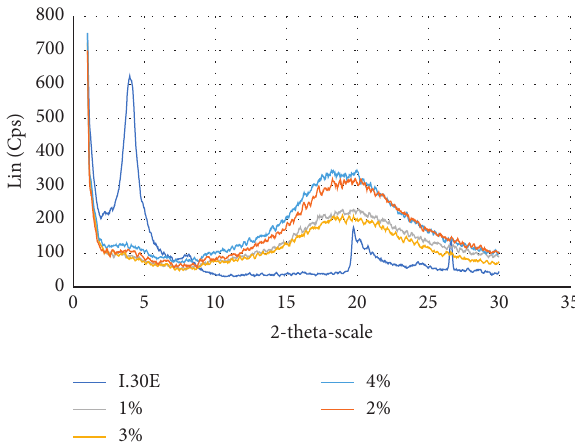
Figure 2: XRD diagram of pure nanoclay and epoxy Epikote 240/nanoclay I.30E nanocomposite